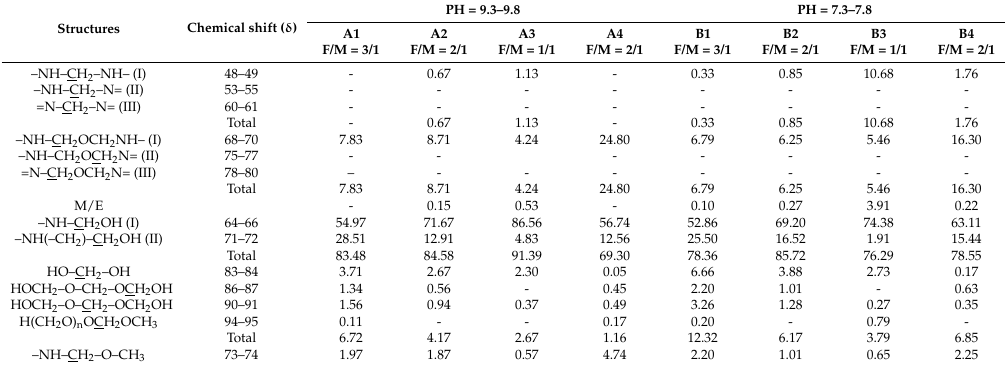
Table 1. The relative content of the methylenic carbons